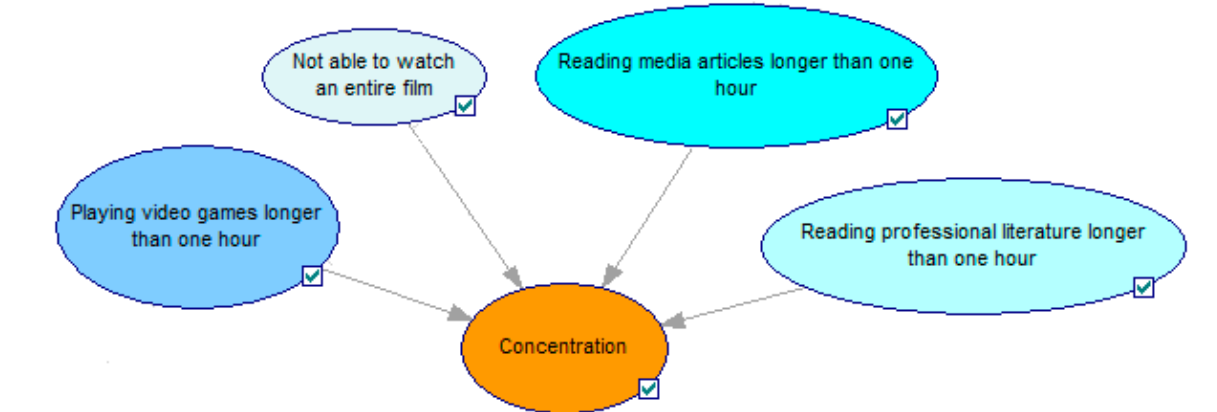
Figure 6. Sub-variables of the node Concentration. Source: authors.